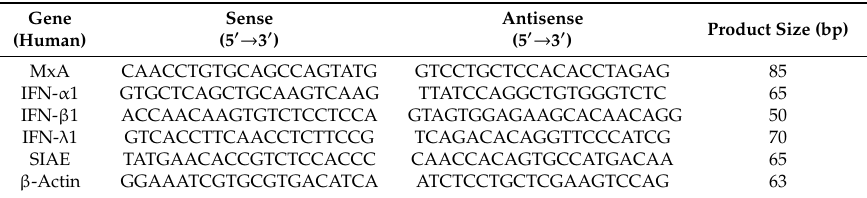
Table 1. Sequences of the human-specific primers used for